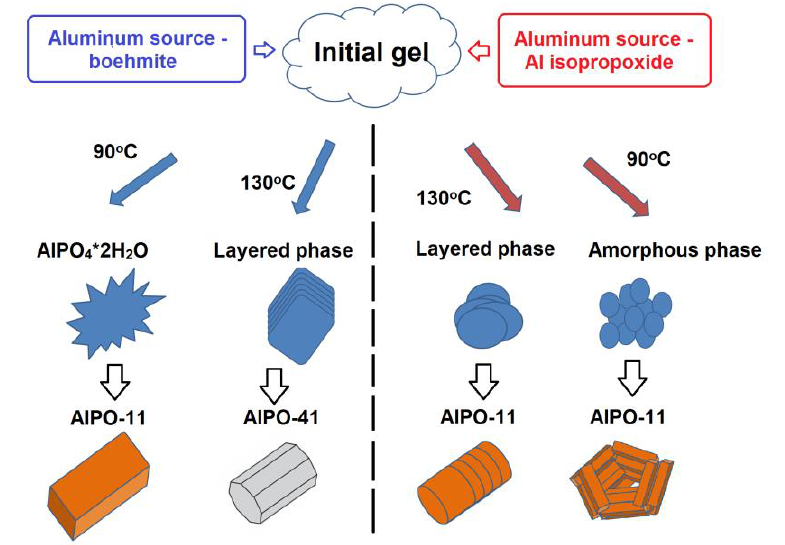
Figure 8. The main stages of crystallization of molecular sieves from intermediate aluminophos- phate phases.